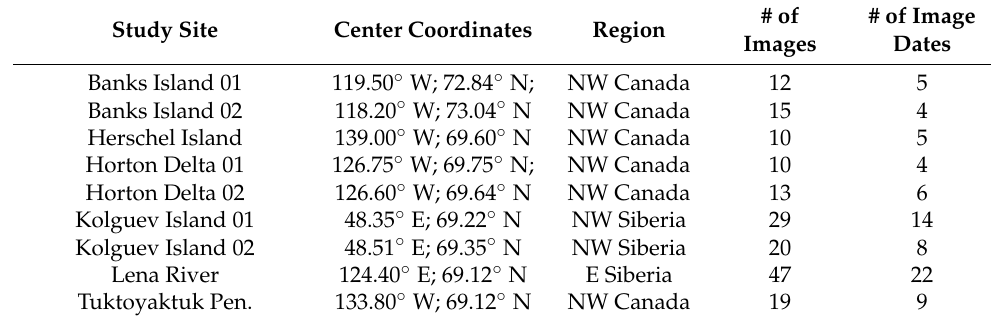
# of # of Image Images Dates